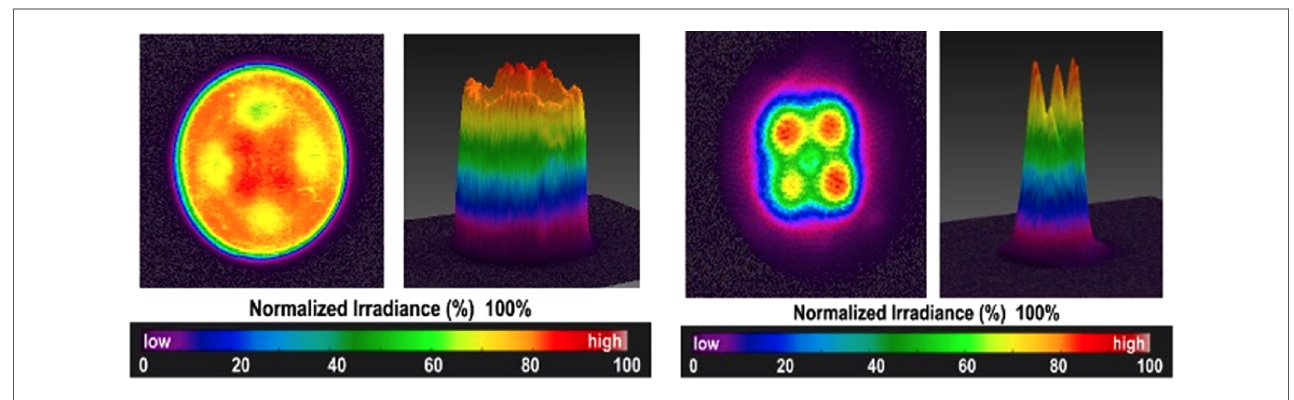
FIGURE 3 Beam pro fi les measured for well-designed LED-LCUs. Both these units emit light from 2×2 arrays of solid-state chips.